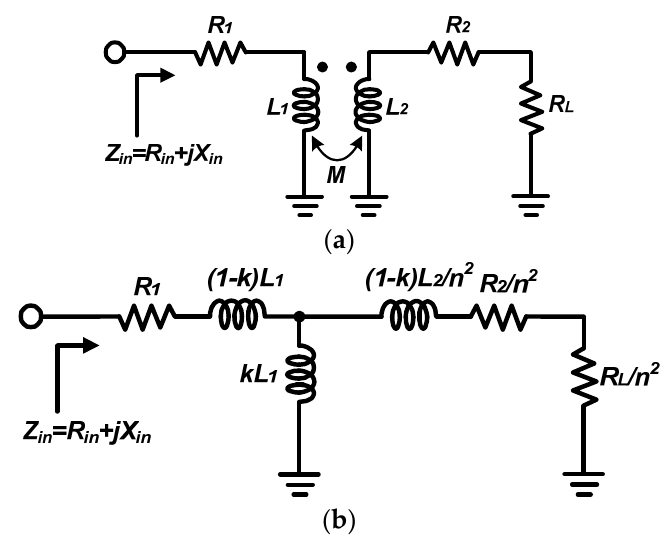
Figure 15. ( a ) Transformer model. ( b ) Transformer equivalent T-model.